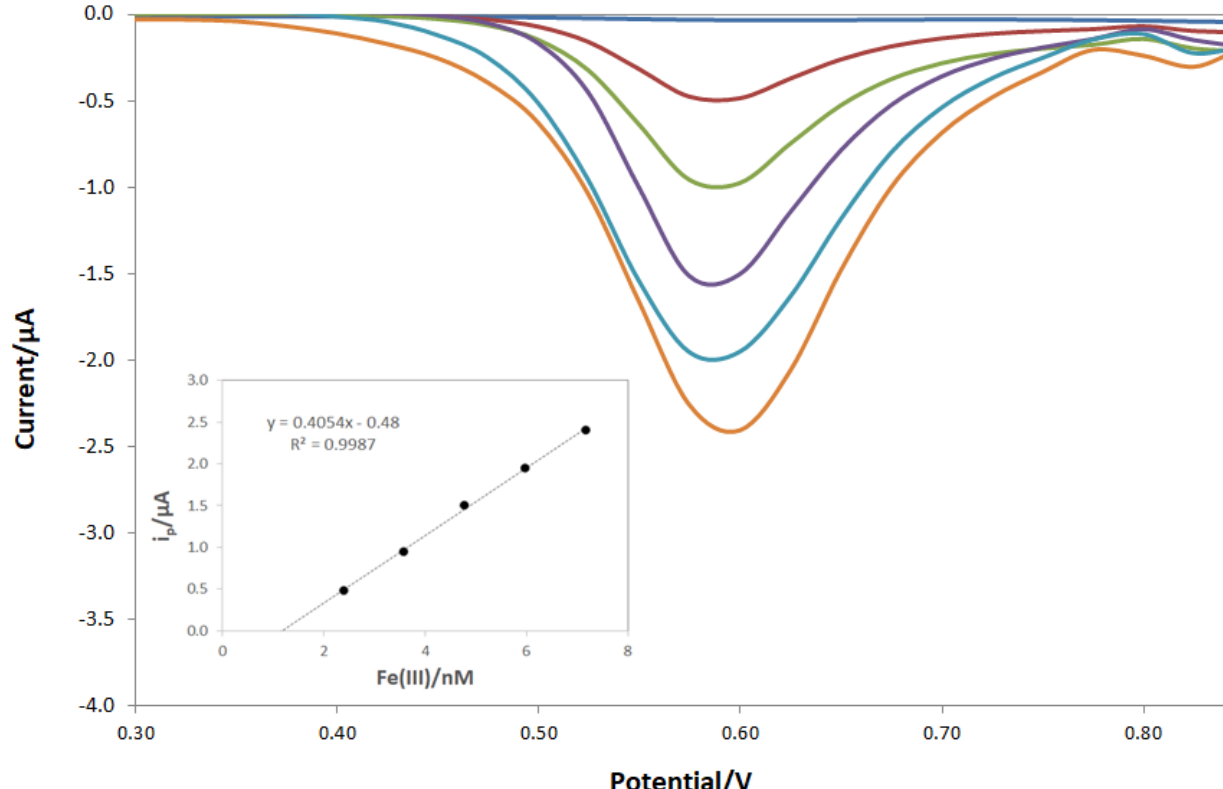
Table 3. Cations’ content of the simulated tap water sample without iron(III).